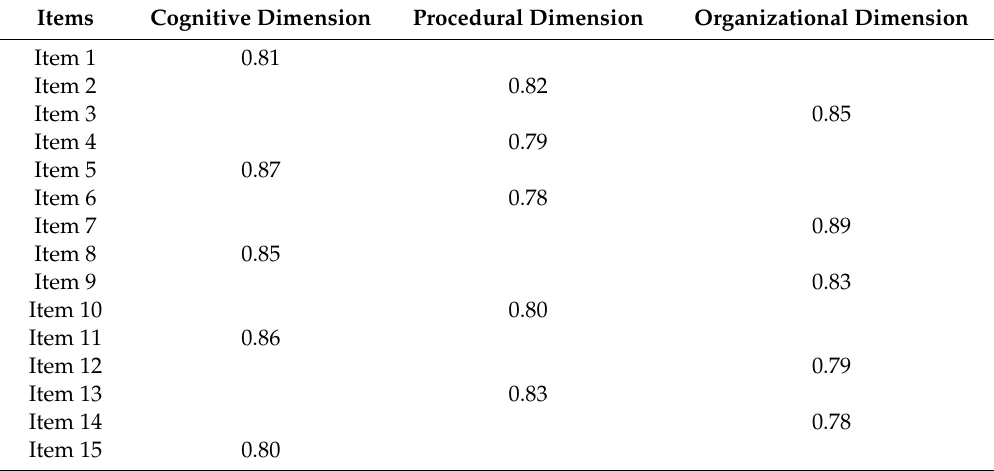
Table 1. Loadings from the EFA.